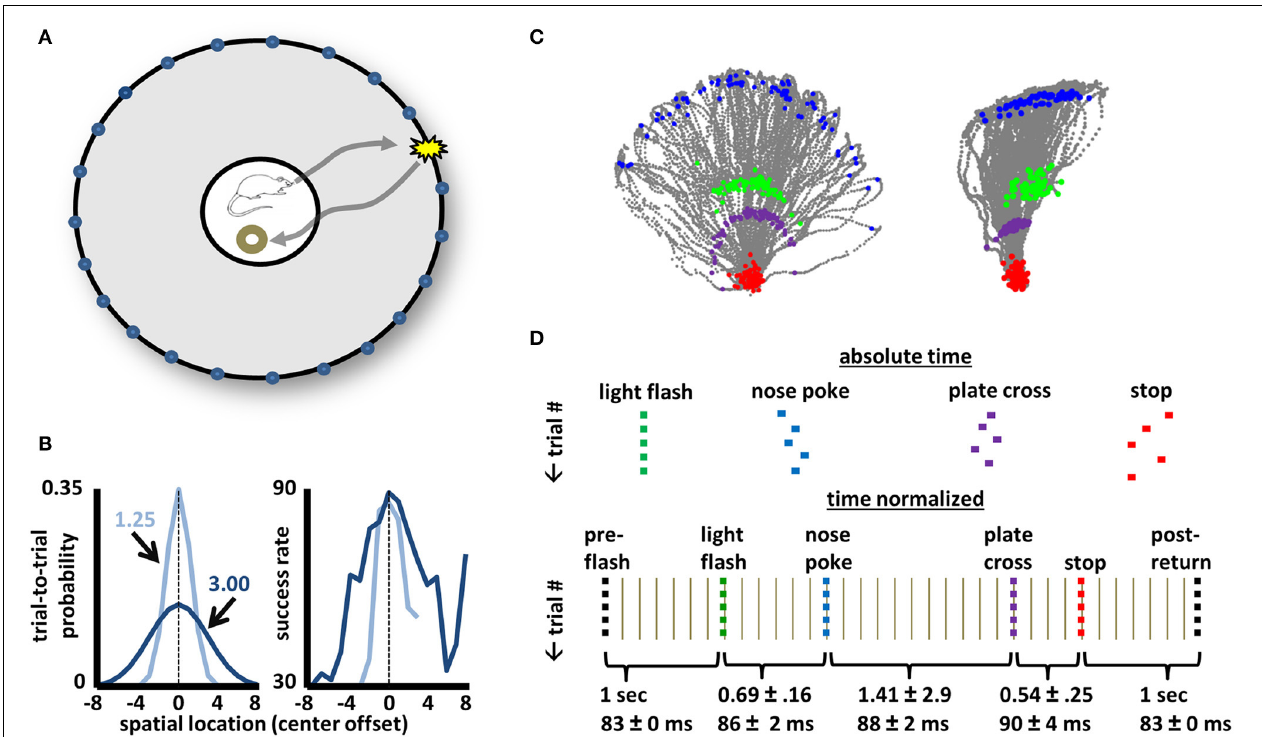
FIGURE 1 | Design, performance, and task phase identification for a selective-attention task. (A) A schematic of the arena used for the selective attention task. A 1.2m-diameter environment with 46cm walls having 36 evenly-spaced light sources each 6.5cm above the surface. A trial begins when the animal stands upon the 25cm plate at the arena center with head orientation such that the location of any individual trial’s light flash lies within a 120-degree space centered on the animal. A light flash (150ms) from a single location triggers a journey to identify the spatial location of the flash with a nose-poke. Return to the center plate yields 1/2–piece Cheerio reward if the correct light source was identified. (B) Left panel: Two trial-by-trial probability distributions (Gaussians with 1.25 or 3.0 SD ) from which the light source locations were chosen randomly for any given animal/recording. Right panel: Average success rates for all animals across all recording sessions approximately match the shape of the light-source probability distributions. (C) Tracking data for all correct trials for recordings utilizing the medium (left image) and narrow (right image) probability distributions of (B) . For each trial, gray points map the animal’s movement for time periods 1s before light flash until 1s after stop/reward. Green points correspond to the animal’s position